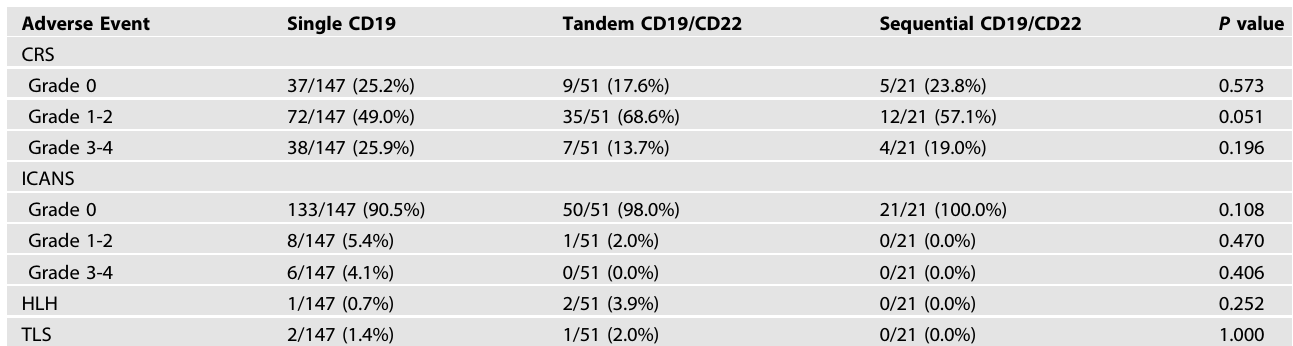
Table 3. Adverse events associated to CAR T-cell